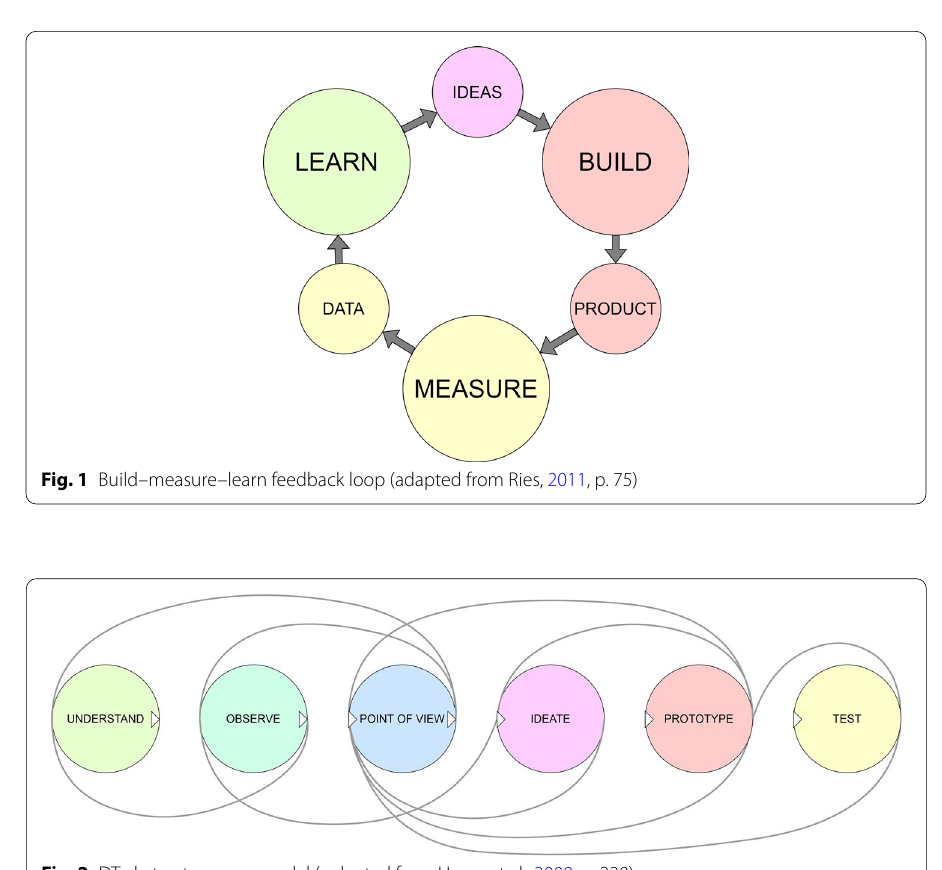
Fig. 2 DT abstract process model ( adapted from Hasso et al., 2009, p.